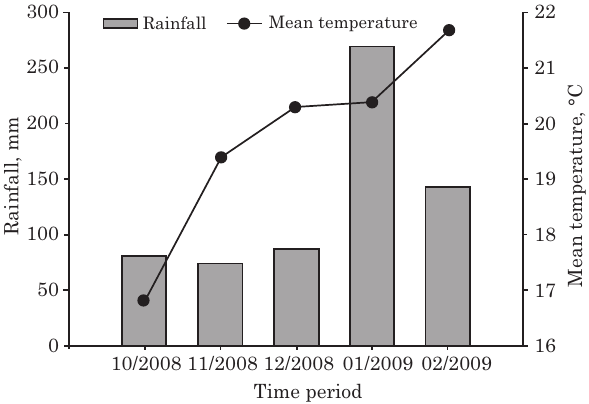
Figure 1. Mean monthly temperature and rainfall values observed while carrying out the